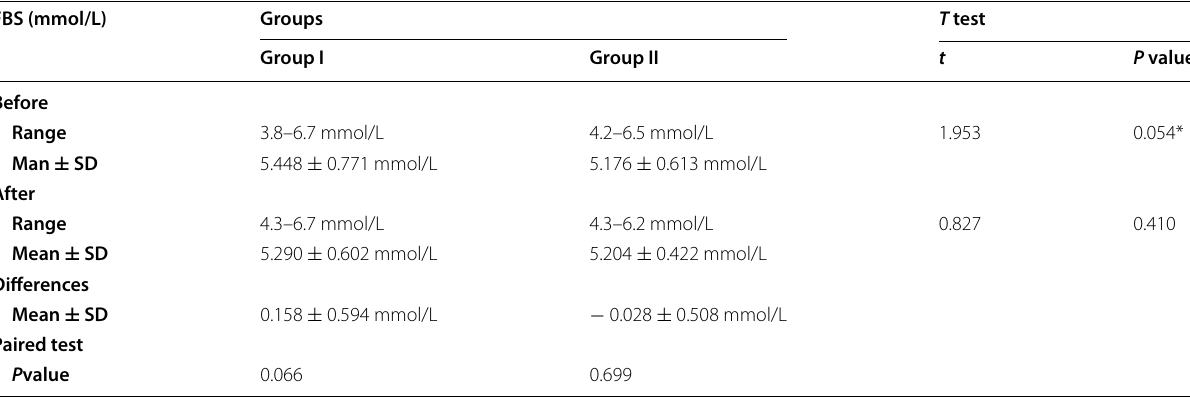
Table 7 Comparison between each group before and after treatment and the two studied groups according to fasting blood sugar